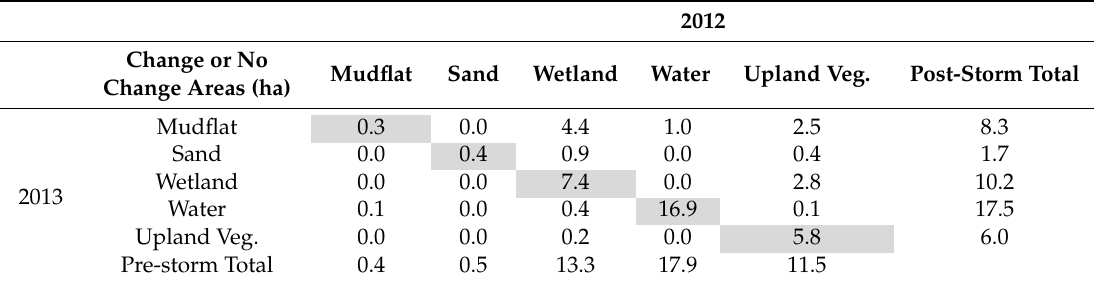
Table 4. Change of land cover classes between 2012 and 2013 for West Pond area.